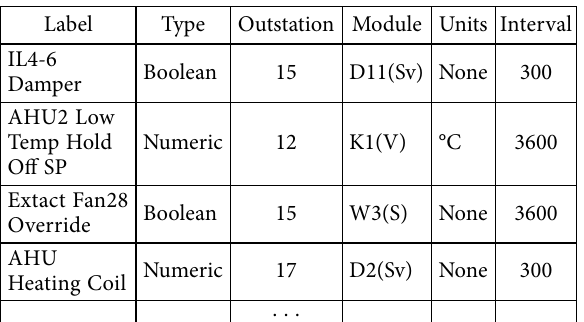
Table 2. Extraction of BMS raw data Label